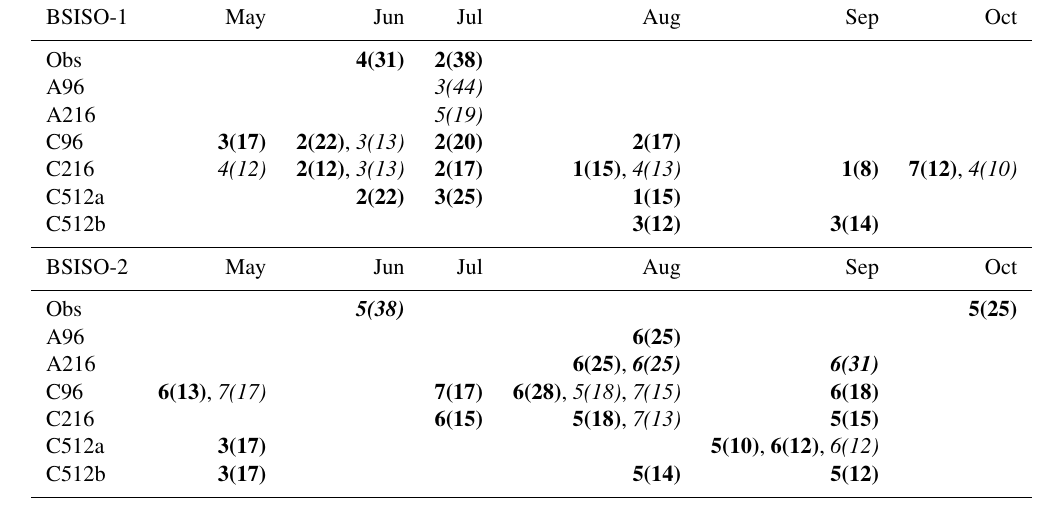
Table 3. BSISO-1 and BSISO-2 phases with an anomalously high occurrence of the wettest 10% of pentads associated with Pattern 1 (bold), Pattern 2 (italic), and Pattern 3 (bold–italic). For each shown number the percentage of occurrence (shown in brackets) is statistically significantly increased at the 5% level compared to the monthly climatology, as indicated by a two-sided binomial test.